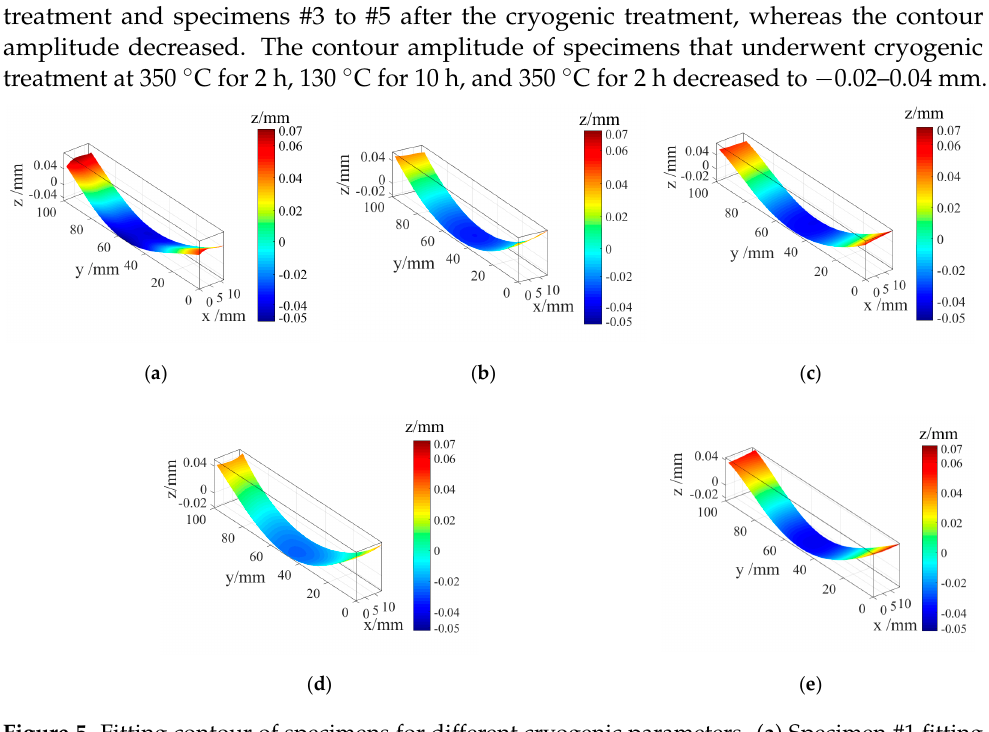
Figure 5. Fitting contour of specimens for different cryogenic parameters. ( a ) Specimen #1 fitting contour. ( b ) Specimen #2 fitting contour. ( c ) Specimen #3 fitting contour. ( d ) Specimen #2 fitting contour. ( e ) Specimen #2 fitting contour.